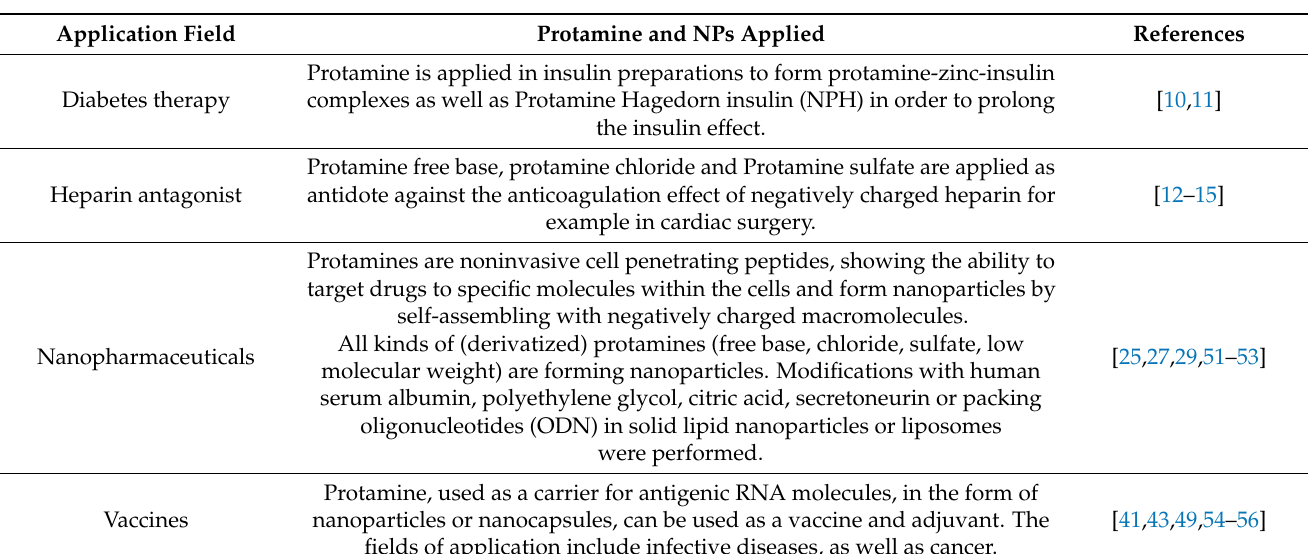
Table 1. Overview of the application fields of